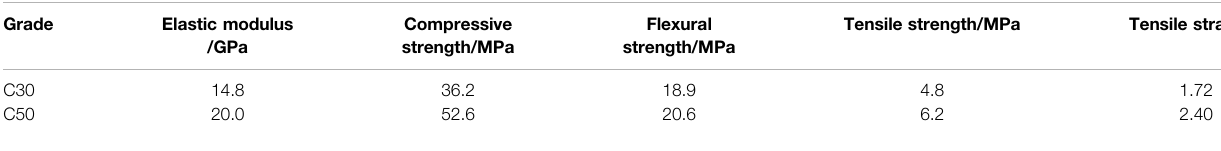
TABLE 4 | Material parameters of